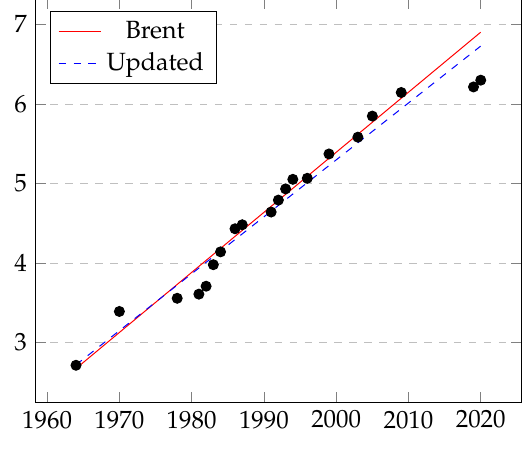
Figure 3. D 1/3 versus year Y.